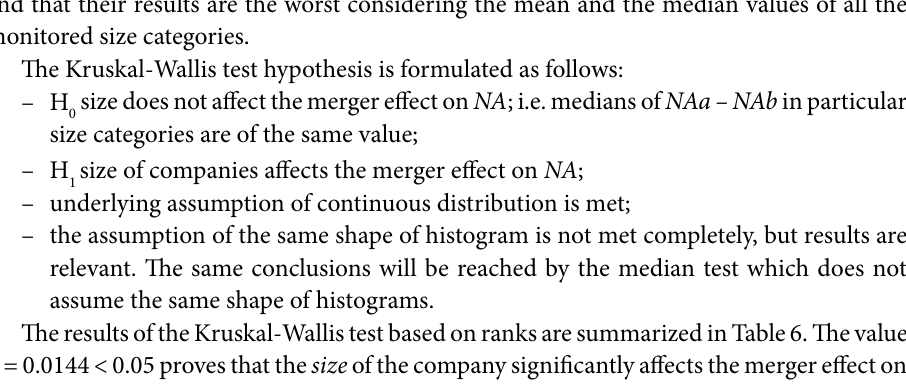
Fig. 3. Box plot of the difference of net assets before and after a merger ( NAa – NAb ) by size